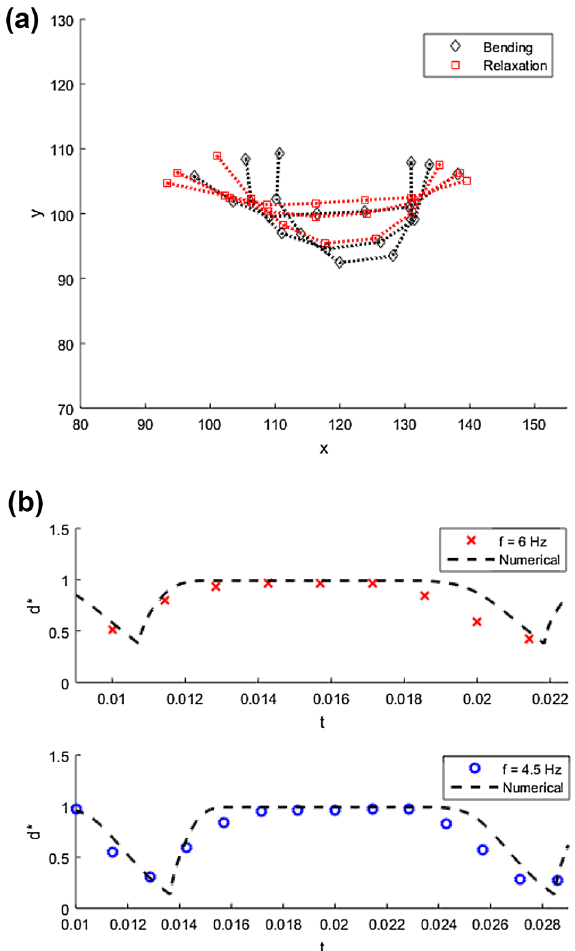
Figure 5. ( a ) Experimental filament configurations showing the difference in bending and relaxation stages at a constant time step over one period. ( b ) End to end x-displacement of filament tips ( d ∗ ) vs time. Scatter points for experimental data for filament with length L = 48 µ m, H = 5.2 Oe, frequency f = 6 Hz (cross) and f = 4.5 (circle). Dashed line shows numerical simulation results of d ∗ ; Cm = 30 , (cid:31) = − 0.2 , T /τ = 0.011 (upper plot) and T /τ = 0.014 (lower